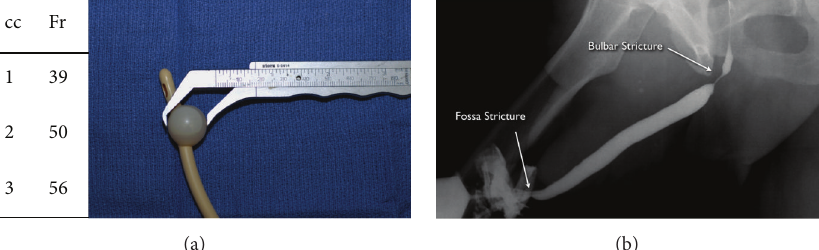
Figure 4: (a) Catheter balloon inflation with only 1–3 cc of air or fluid is associated with balloon inflation well beyond the normal caliber of the normal fossa navicularis. (b) Repeat RUG demonstrating, in addition to the previously seen bulbar stricture, a new fossa navicularis stricture that developed after a RUG was performed using fossa balloon inflation technique.